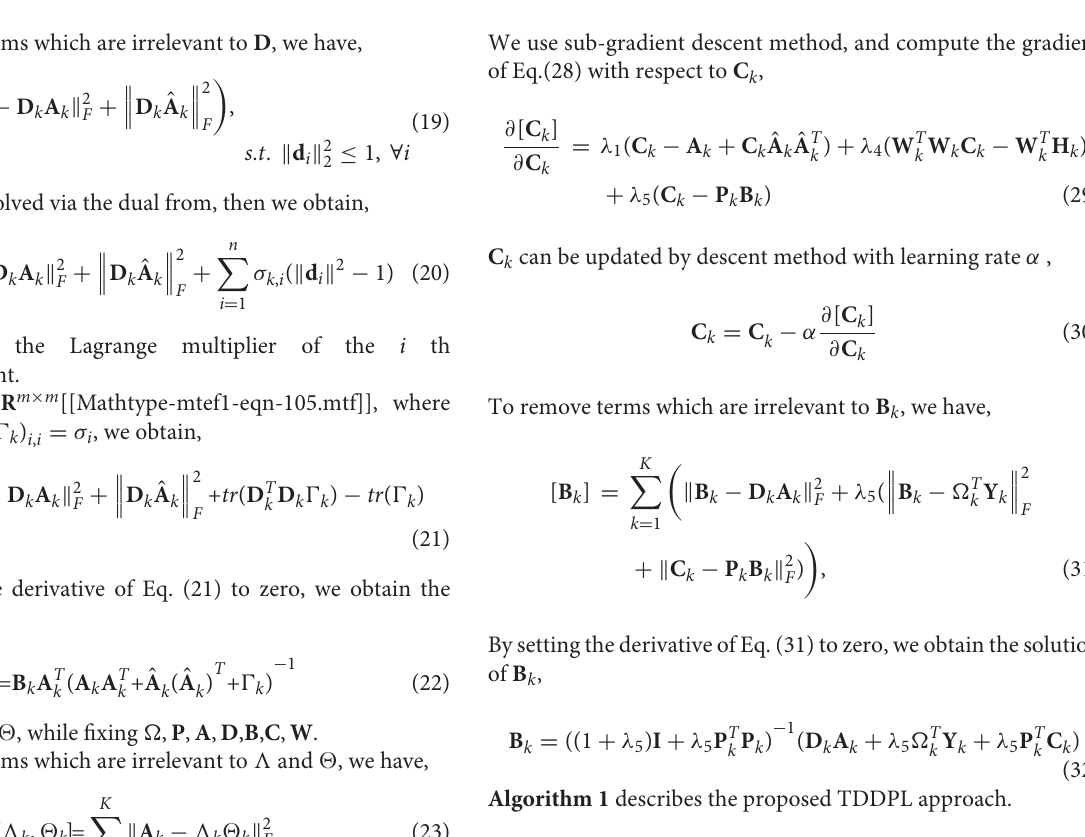
Algorithm 1 describes the proposed TDDPL approach.